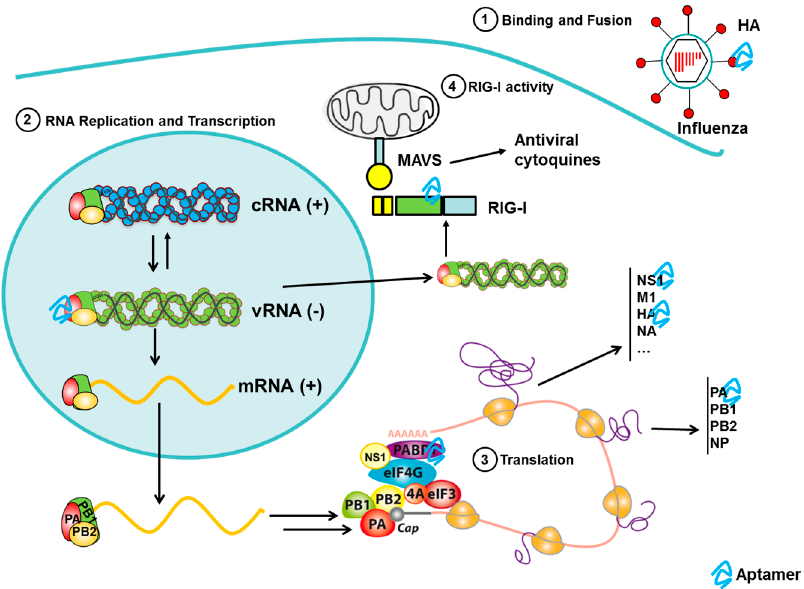
Figure 4. Scheme showing the protein targets for aptamers in influenza virus. ( 1 ) The viral particles, containing the segmented genome, present in its surface high amounts of hemagglutinin (HA) required for binding and fusion with the host cell; ( 2 ) The enveloped negative-strand viral RNA produces a full length (+) which in turn is copied to a full-length ( − ) strand RNA then used to assembled new virions. The vRNA serves as template for the synthesis of mRNA. The mRNAs of influenza virus possess a 5 ′ cap structure and a 3 ′ poly(A) tail that makes them structurally indistinguishable from cellular mRNAs; ( 3 ) Model of Influenza mRNA translation: The association of the viral polymerase, bound to the cap, and eIF4GI may be involved in the preferential translation of viral mRNAs during influenza infection. In addition, the interaction of NS1, bound to a conserved 5- untranslated region (UTR) element of the viral mRNA, with eIF4GI and PABP1 could promote the formation of a “closed loop” between the 5 ′ and 3 ′ ends of the viral mRNA; ( 4 ) RIG-I is a cytosolic receptor for non-self RNA that mediates immune responses against viral infections through IFN α / β production. Mitochondrial antiviral-signaling (MAVS) protein.